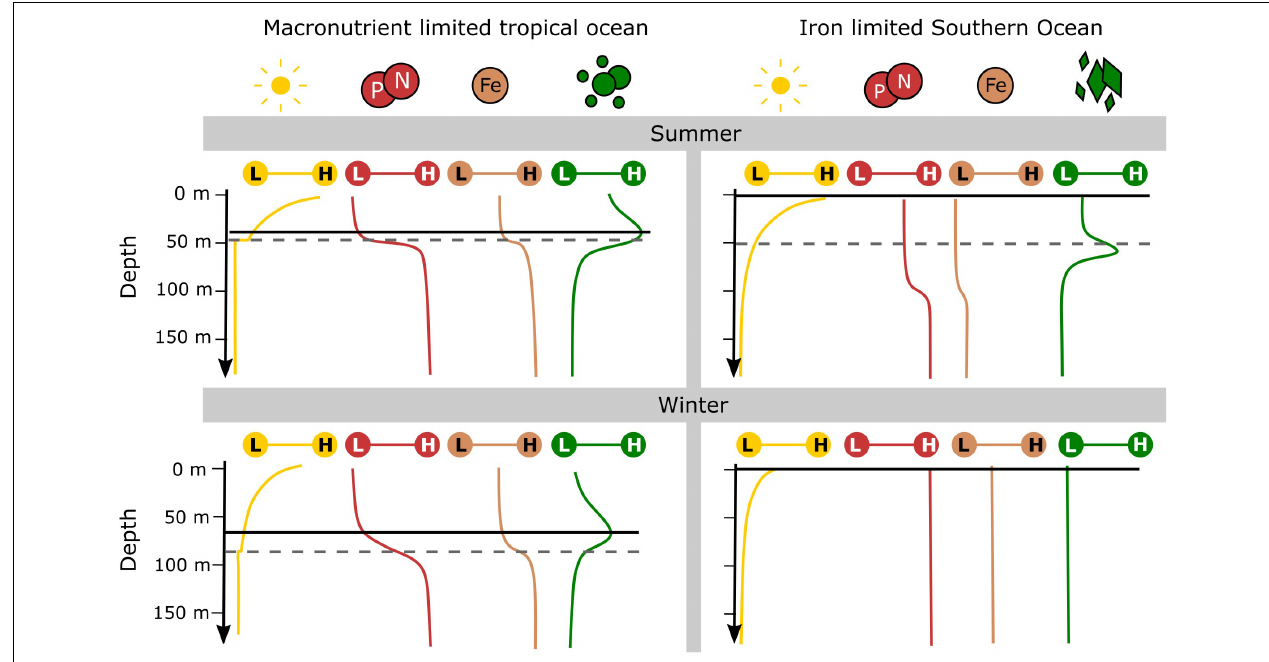
FIGURE 1 | A comparison of typical upper water column structure between the macronutrient limited tropical ocean and the iron limited Southern Ocean over summer and winter. Distributions of downward irradiance (yellow), macronutrients (red) and iron (brown) are shown on a low (L) to high (H) scale. Also shown are indications of mixed layer depths (dashed gray line) – note that mixed layer depths are highly variable and are dependent on the thresholds used to define them. Phytoplankton distributions (green) are shown for the picophytoplankton (circular) community of the tropical ocean and the high silicate community (diamond) of the polar Southern Ocean. The optimum depth of phytoplankton growth (solid black line) is determined by the distribution of light and the limiting nutrient according to the theory of nutrient light co-limitation. Supplementary Table S1 lists supporting information used in the construction of this graphical